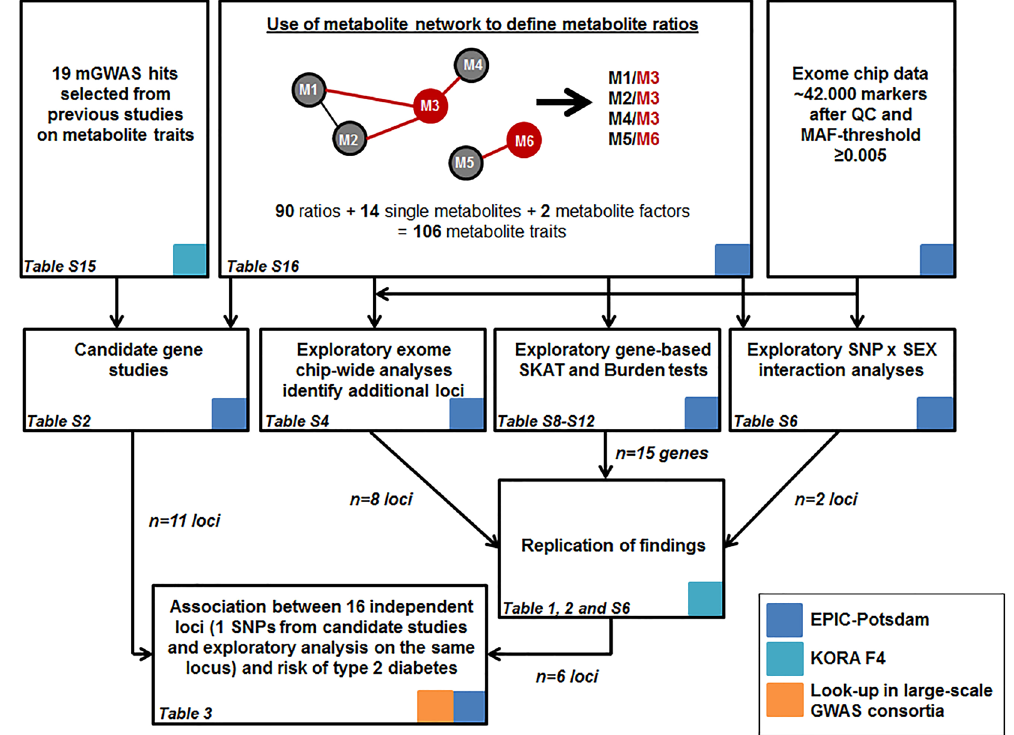
Figure 1. Flowchart of the analytical strategy. The red circles indicate diabetes-associated metabolites and grey circles depict other metabolites. The colored squares indicate data sources used in the different steps of the analysis. GWAS, genome-wide association study; MAF, minor allele frequency; QC, quality control; SNP, single nucleotide